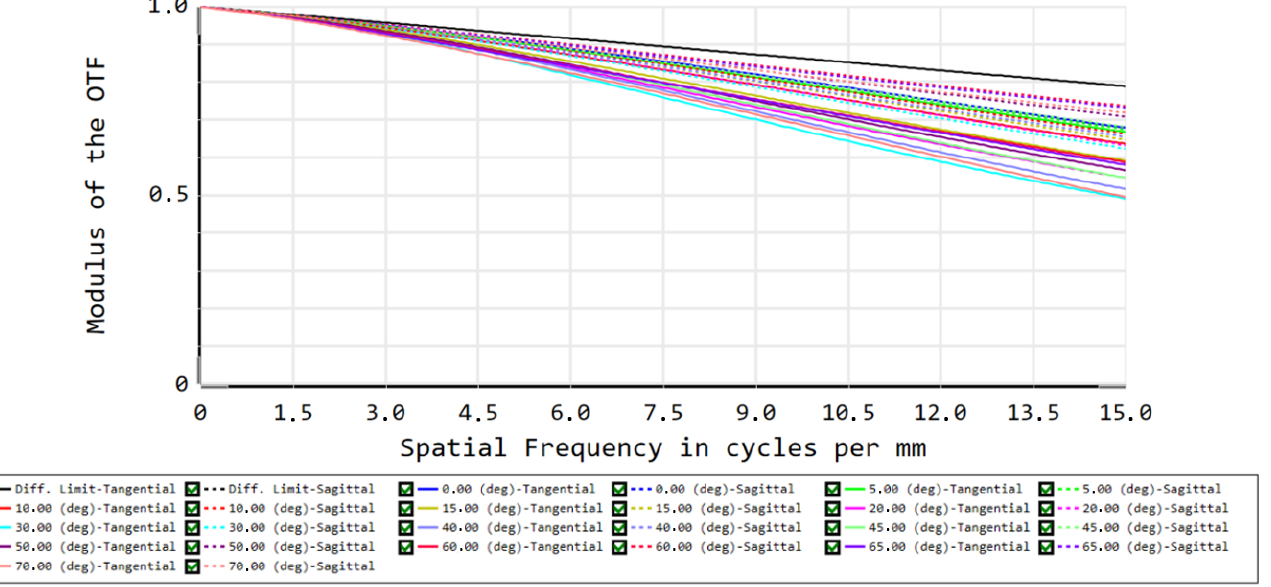
Figure 6. MTF ≥ 0.5 at 15 cycles/mm. The top black line corresponds to the diffraction limit, and the colors correspond to the different fields, similar to those in Figure 1. Full lines and dashed lines correspond to tangential and sagittal planes, respectively.